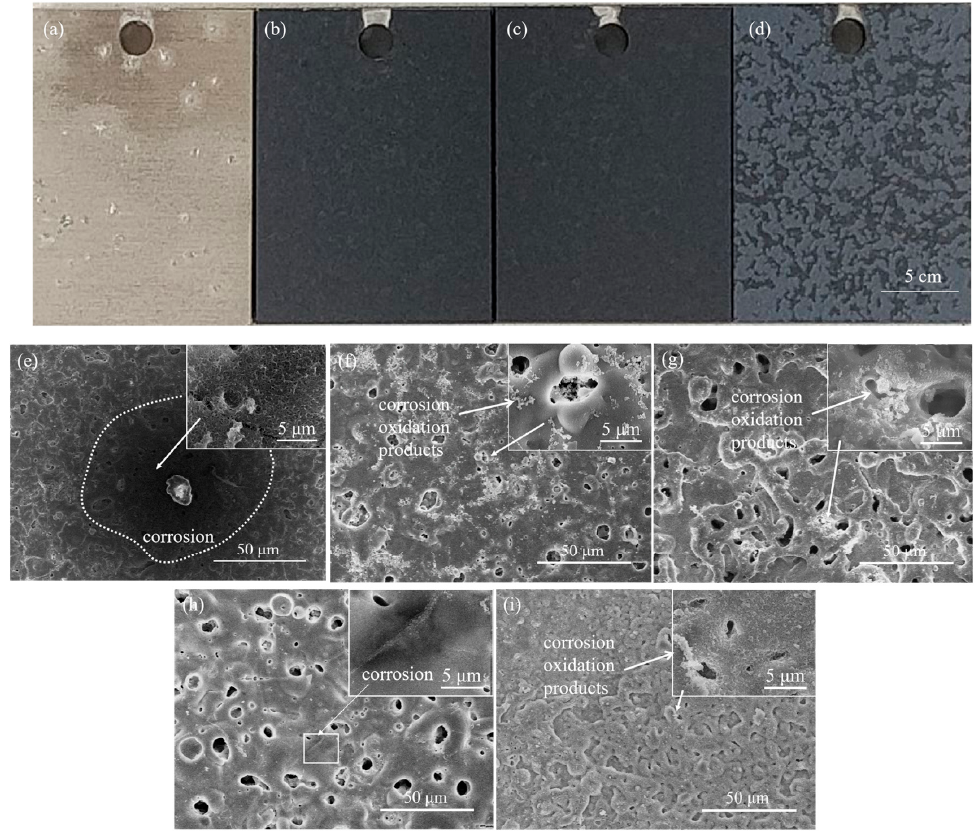
Figure 11. Digital photographs and SEM images of different samples after soaking in 3.5% sodium chloride solution for 336 h: ( a , e ) Ti0 ‐ 15, ( b , f ) Ti5 ‐ 15, ( c , g ) Ti5 ‐ 25 and ( d , h , i ) Ti5 ‐ 35. chloride solution for 336 h: ( a , e ) Ti0-15, ( b , f ) Ti5-15, ( c , g ) Ti5-25 and ( d , h , i )